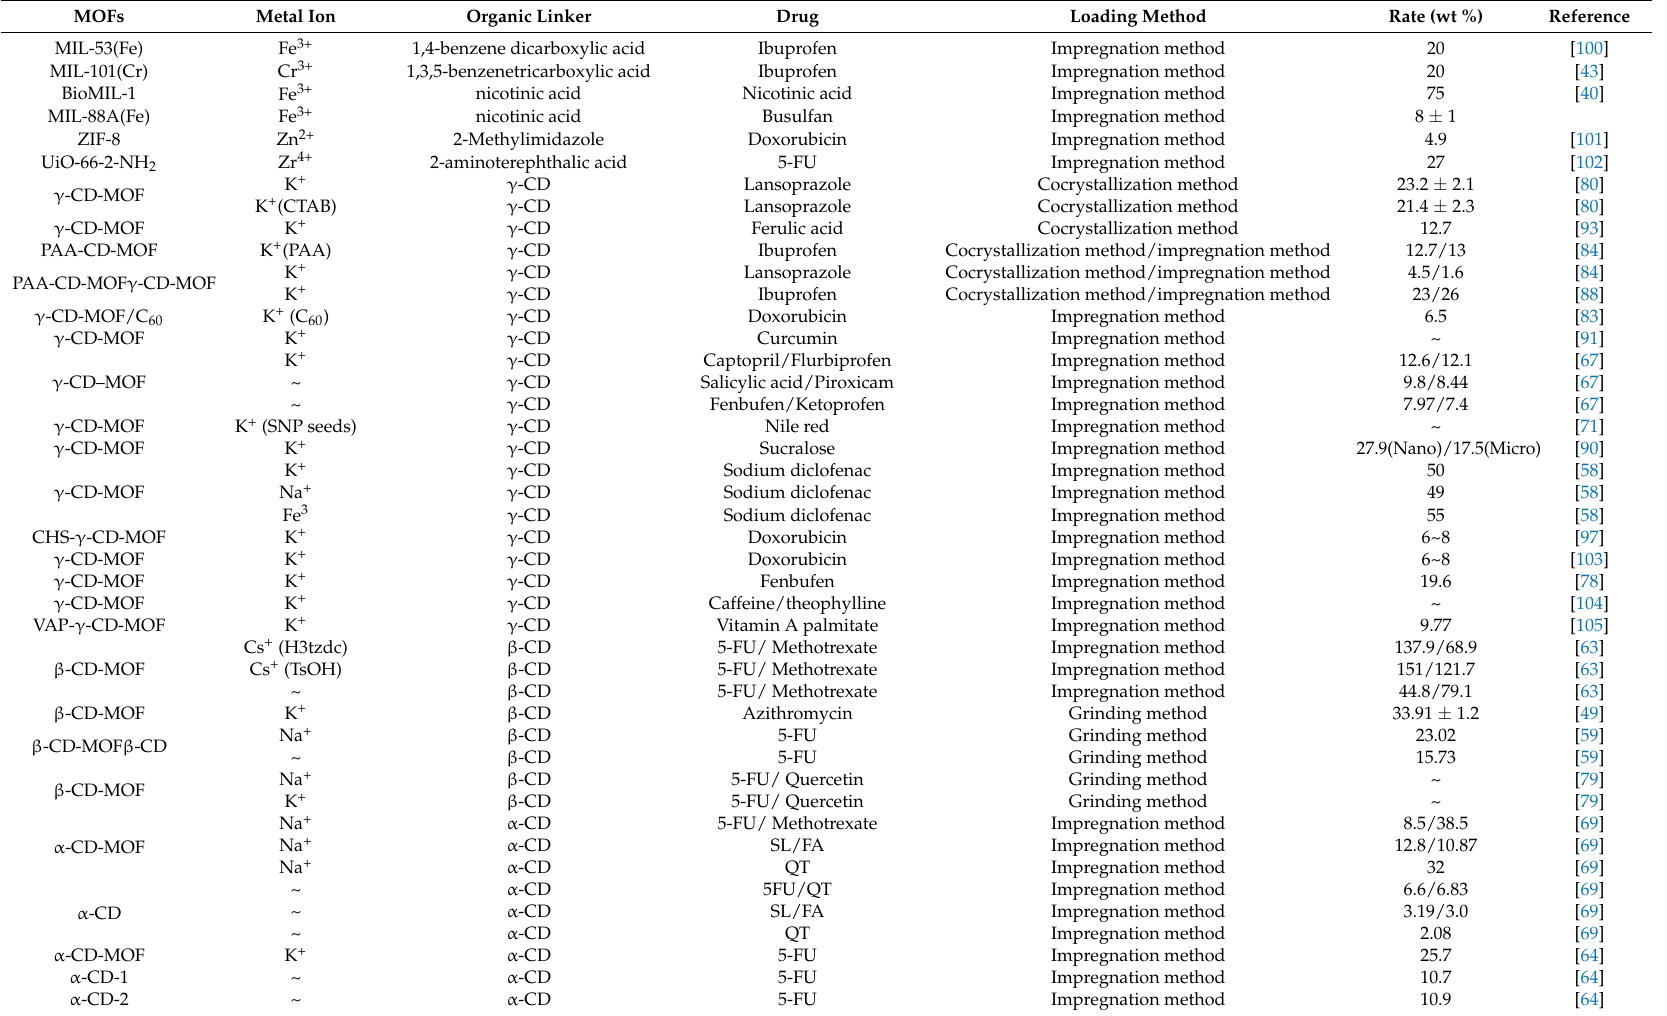
Table 2. Overview of drug encapsulation in classical MOF particles and